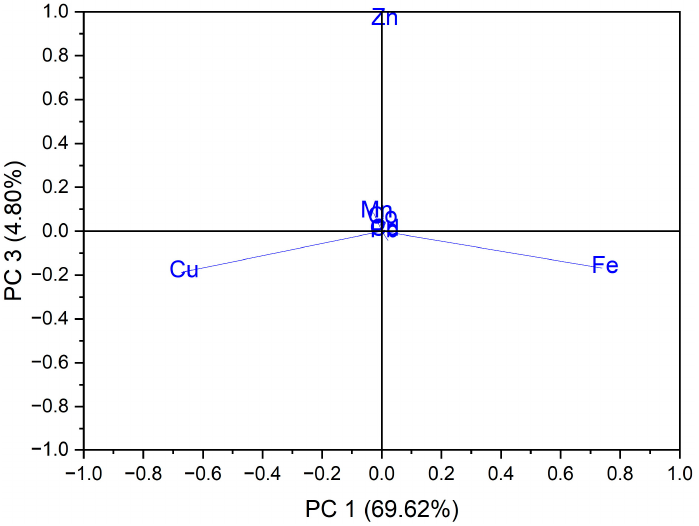
Figure 6. Chart of records of PC3 vs. PC1 for PCA analysis, using as input data the content of trace elements for the analyzed vegetable samples.